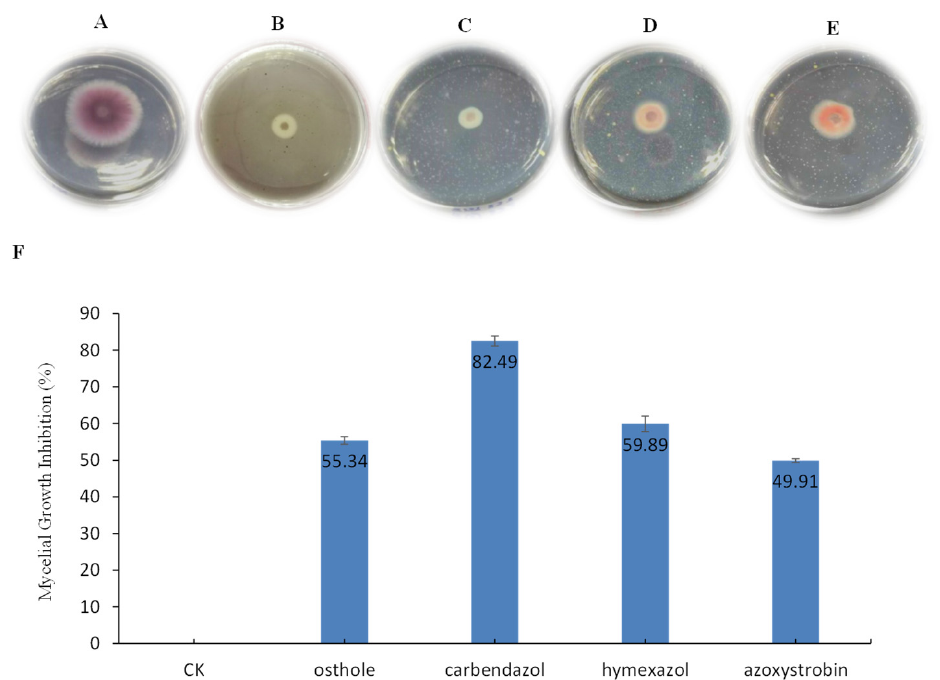
Figure 1. The inhibitory effect of osthole on Fusarium oxysporum at 3 days after inoculation. ( A ) CK, potato dextrose agar (PDA) medium; ( B ) PDA medium plus 5 mg/mL osthole; ( C ) PDA medium plus 5 mg/mL carbendazol wettable powder; ( D ) PDA medium plus 5 mg/mL hymexazol aqueous solution; ( E ) PDA medium plus 5 mg/mL azoxystrobin; ( F ) The mycelial growth inhibition are shown. CK, PDA medium. The bars on the columns indicate standard deviation.